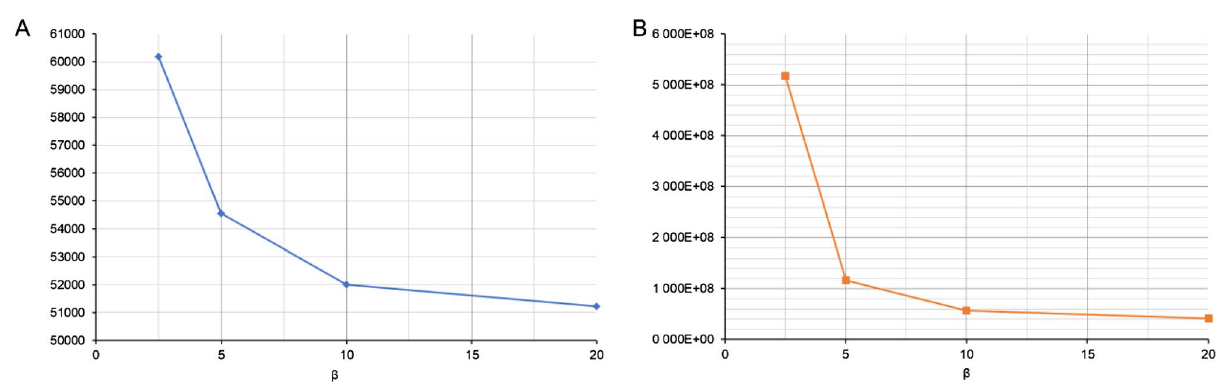
Figure 3. Graphs of activation energy ( A ) and the pre-exponential factor ( B ) as functions of the rate of thermal degradation for the measured